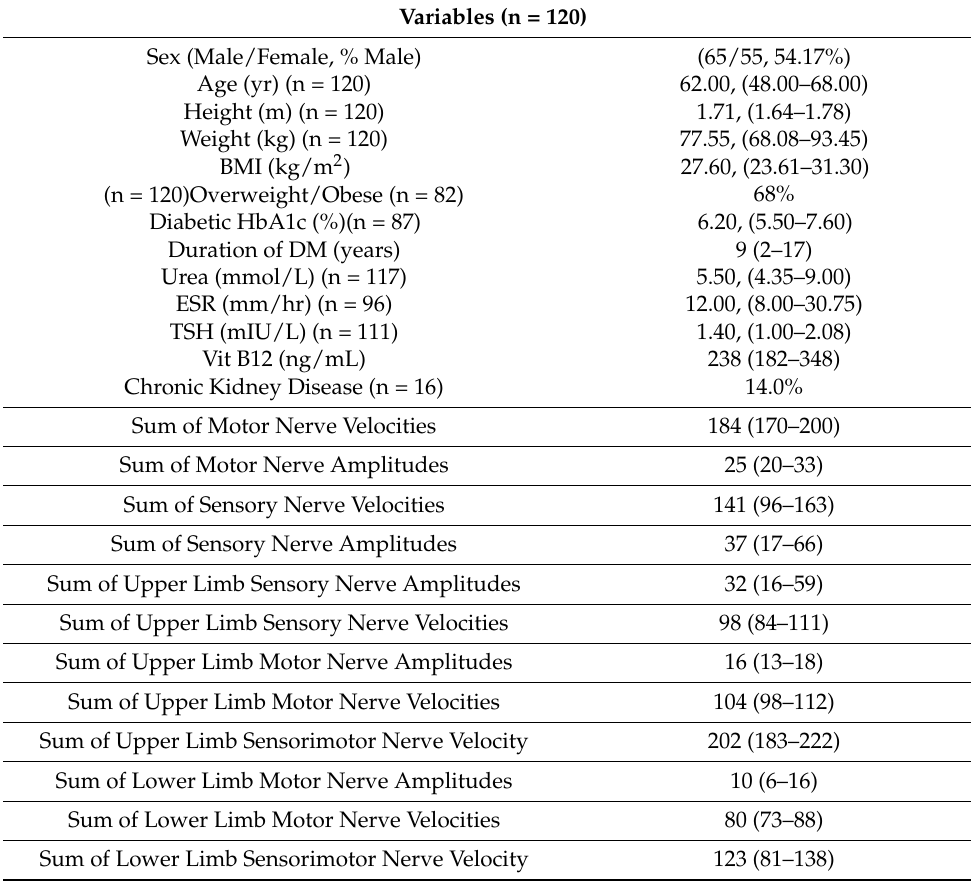
Table 2. Baseline characteristics of